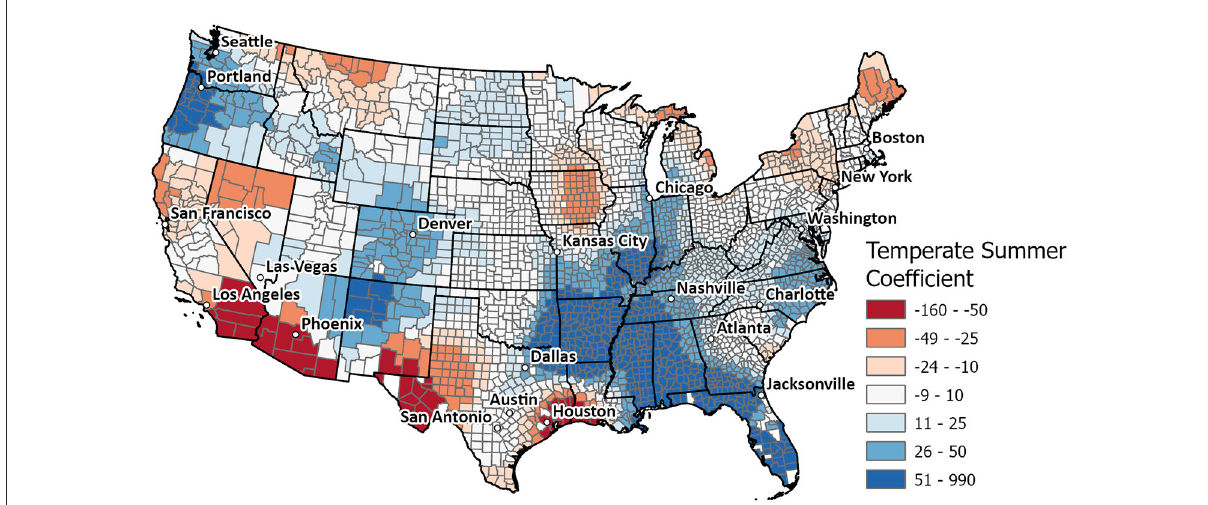
FIGURE6 Local model coefficients for temperate summers in the GWR. Values ranged from regions where people have been moving away from counties with relatively cool summers or toward counties with relatively hot summers. Positive values (in shades of blue) indicate regions where people are moving toward counties with relatively cool summers or away from counties with relatively hot summers.